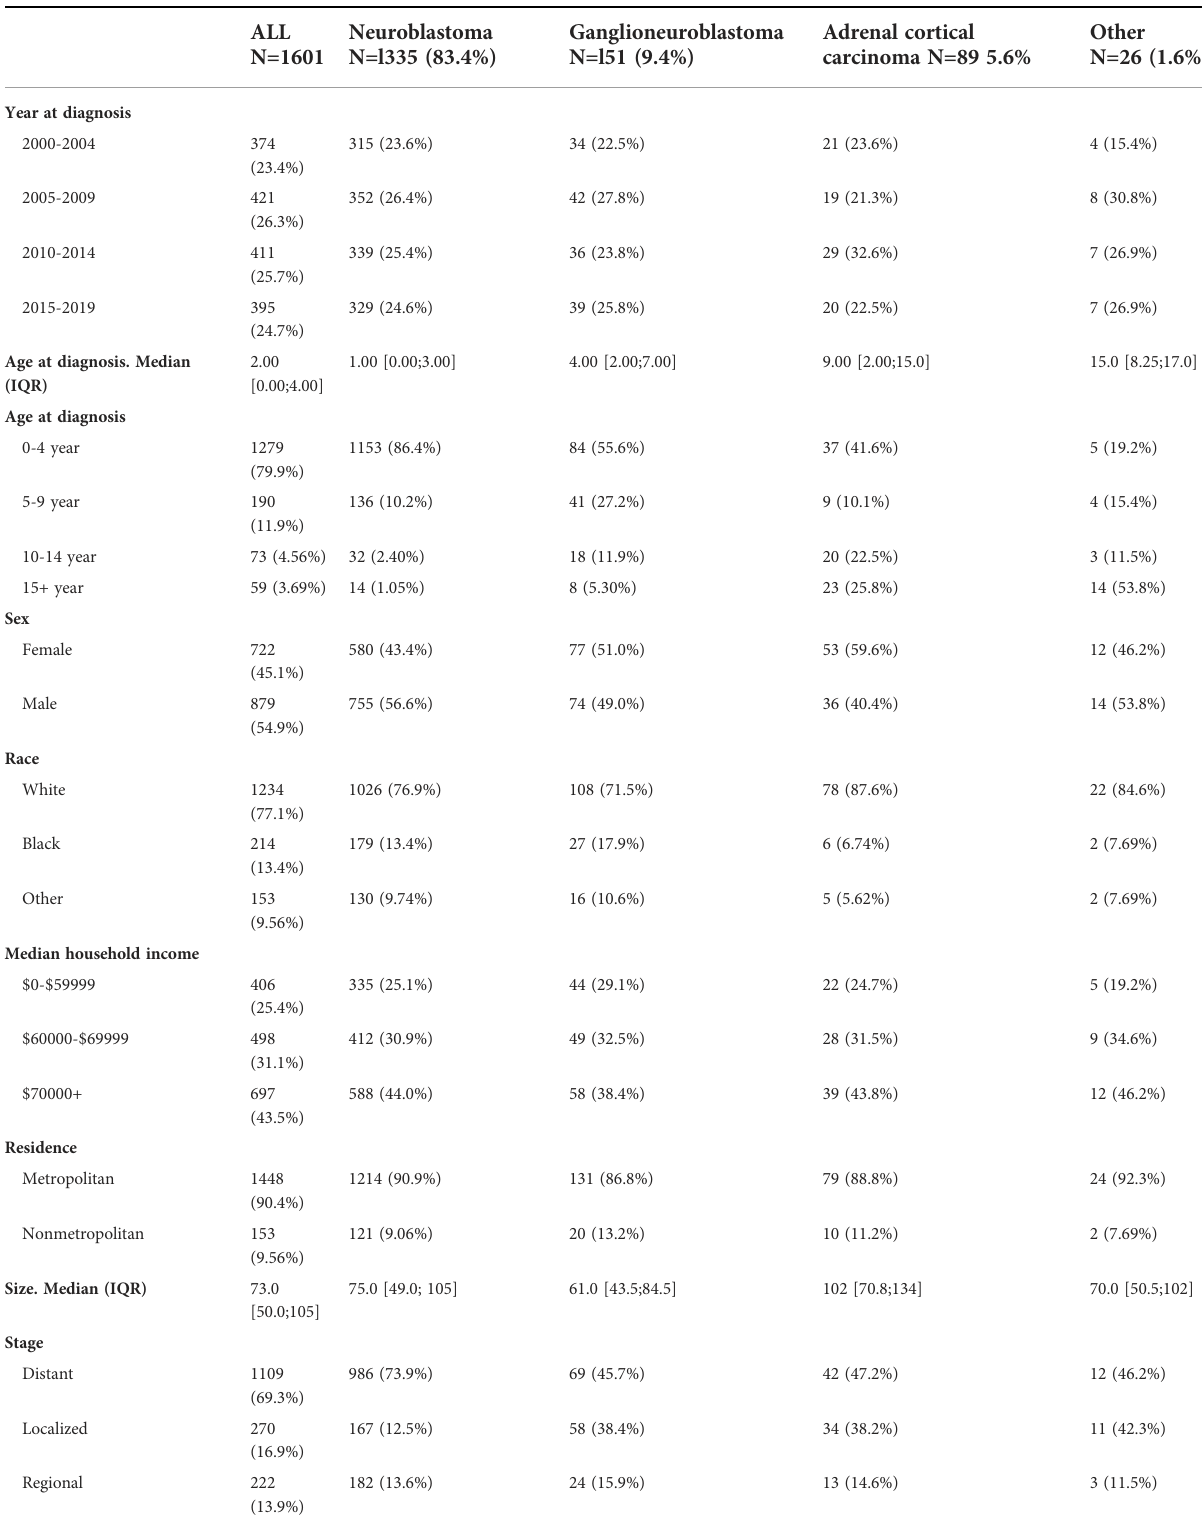
TABLE 1 Baseline characteristics of the study